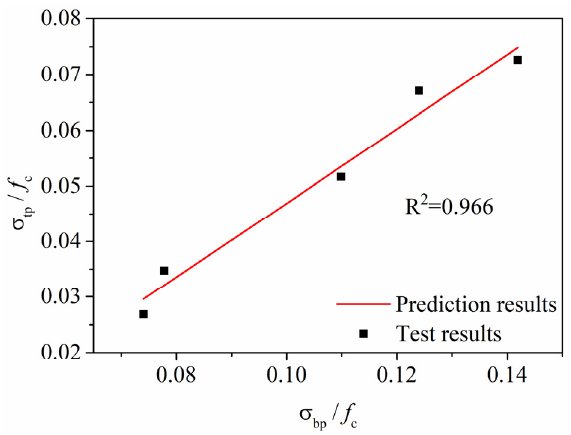
Figure 20. Relationship between σ bp / f c and σ tp / f c .